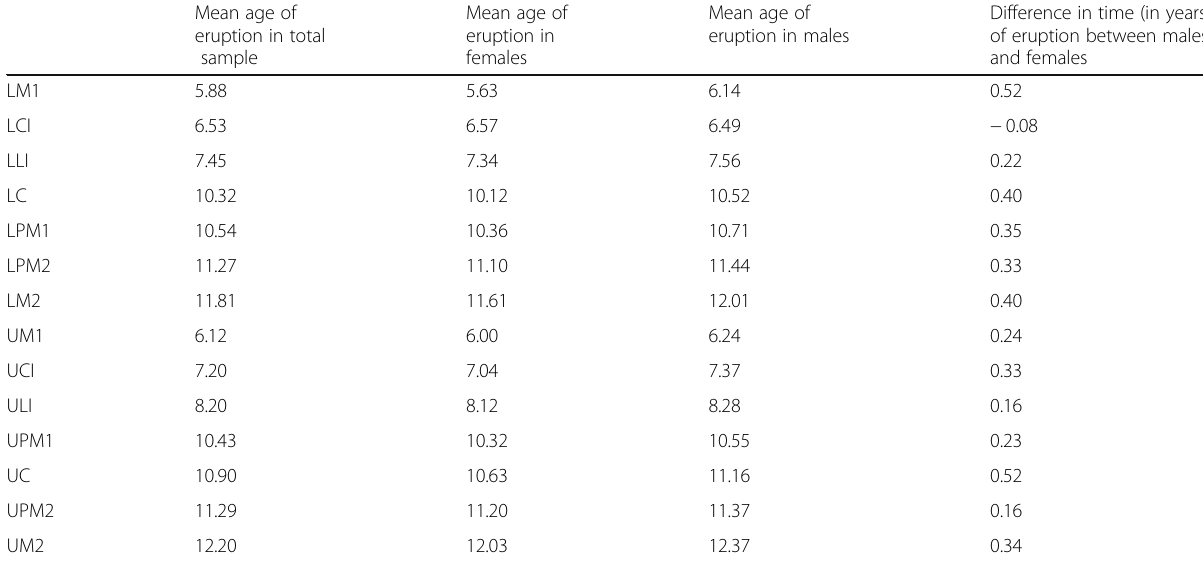
Table 1 Mean age of emergence as obtained from Probit regression model